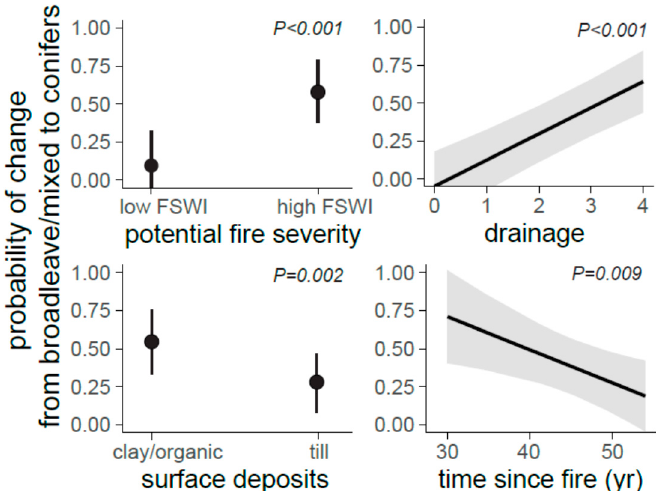
Figure 4. Results of modeling of the probability of change from broadleaved / mixed to coniferous cover. The plots show the predicted values and 95% confidence intervals obtained with the selected linear mixed model that account for sites and fire characteristics without interactions (R 2 fixed = 0.19; R 2 fixed + random = 0.49). Only significant ( p < 0.05) e ff ects are shown. Drainage classes range from bad (0) to good (4).